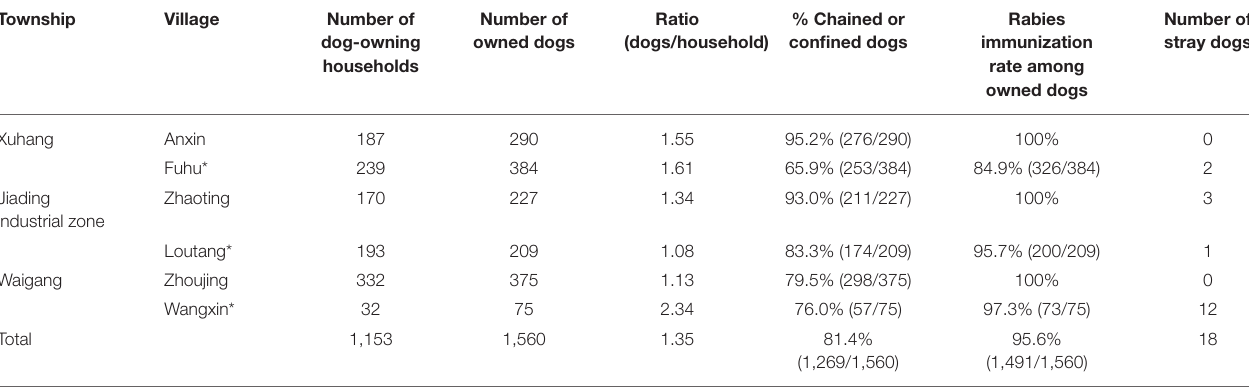
TABLE 2 | The number of dog-owning households, percentage of chained or confined dogs, rabies immunization rate and the number of stray and owned dogs reported in selected model and non-model villages in Jiading district, Shanghai, 2020. Township Village